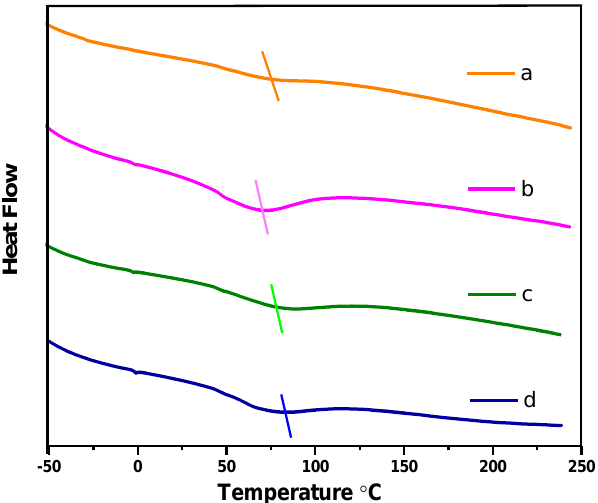
Figure 6. DSC thermograms for PPy.CB 20% and HGPPy.CB 20% ( a ) PPy.CB 20% ( b ) HGPPy.CB 20% 1:3 ( c ) HGPPy.CB 20% 3:7 ( d ) HGPPy.CB 20% 7:13.